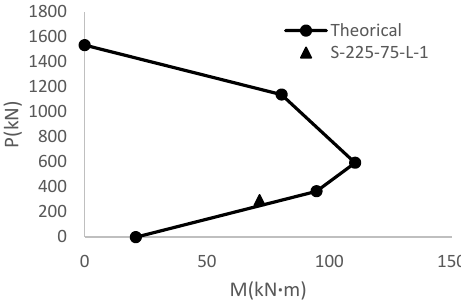
Figure 4. Interaction curve of S ‐ 225 ‐ 75 ‐ L ‐ 1 column.